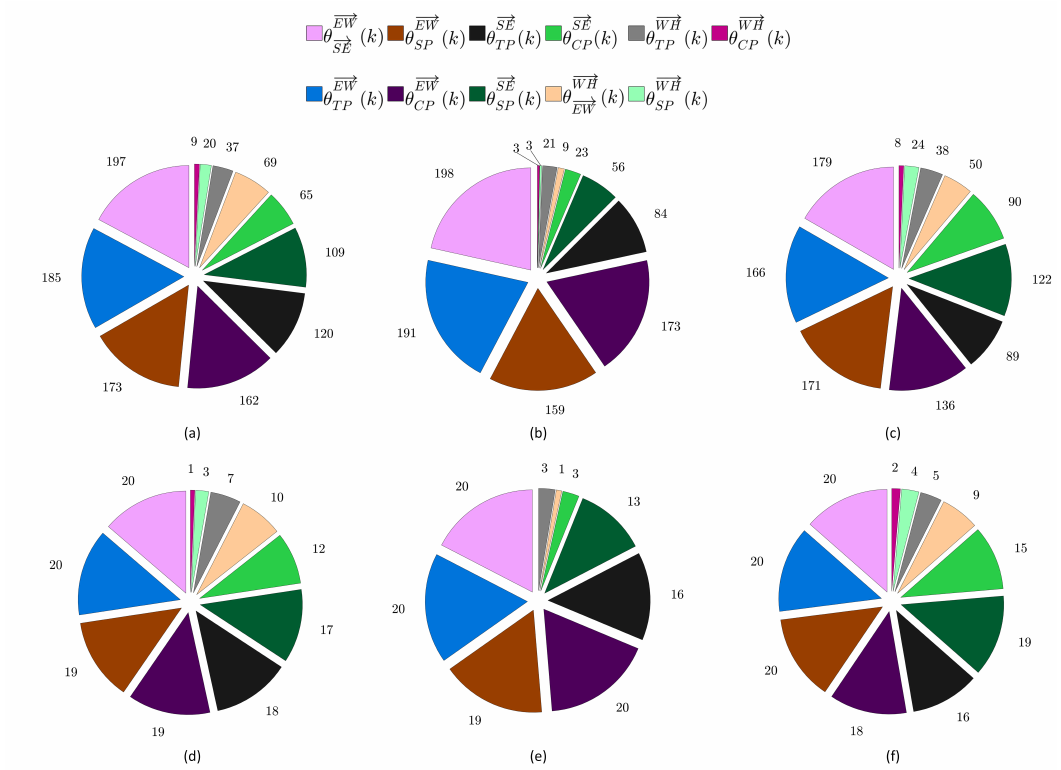
Figure 6. ( a – c ) The CBOFF values computed for the twenty typically developing subjects during their participation in ( a ) the shoulder flexion, ( b ) the shoulder horizontal abduction/adduction, and ( c ) the shoulder adduction game-based exercises. ( d – f ) The PBOFIF values computed for the twenty typically developing subjects during their participation in ( d ) the shoulder flexion, ( e ) the shoulder horizontal abduction/adduction, and ( f ) the shoulder adduction game-based